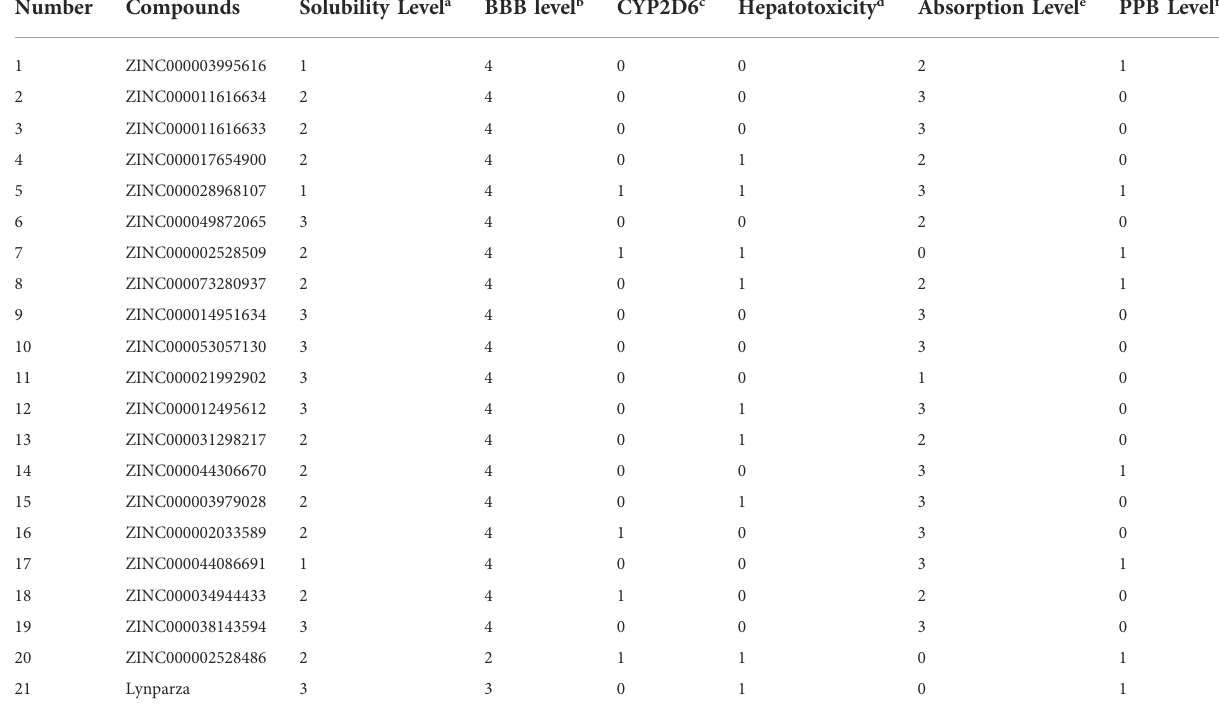
TABLE 2 ADME (Adsorption, Distribution, Metabolism, Excretion) properties of